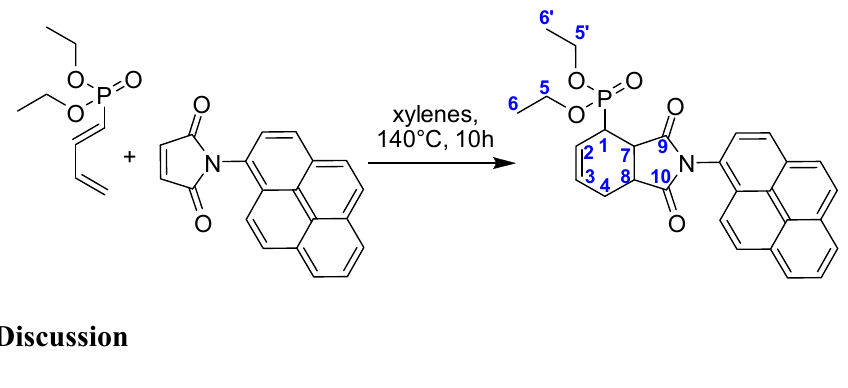
Figure 2. Synthesis of the organic guest molecule (CCNPyr) from 1-phosphono-1,3-butadiene and N -pyrenylmaleimide